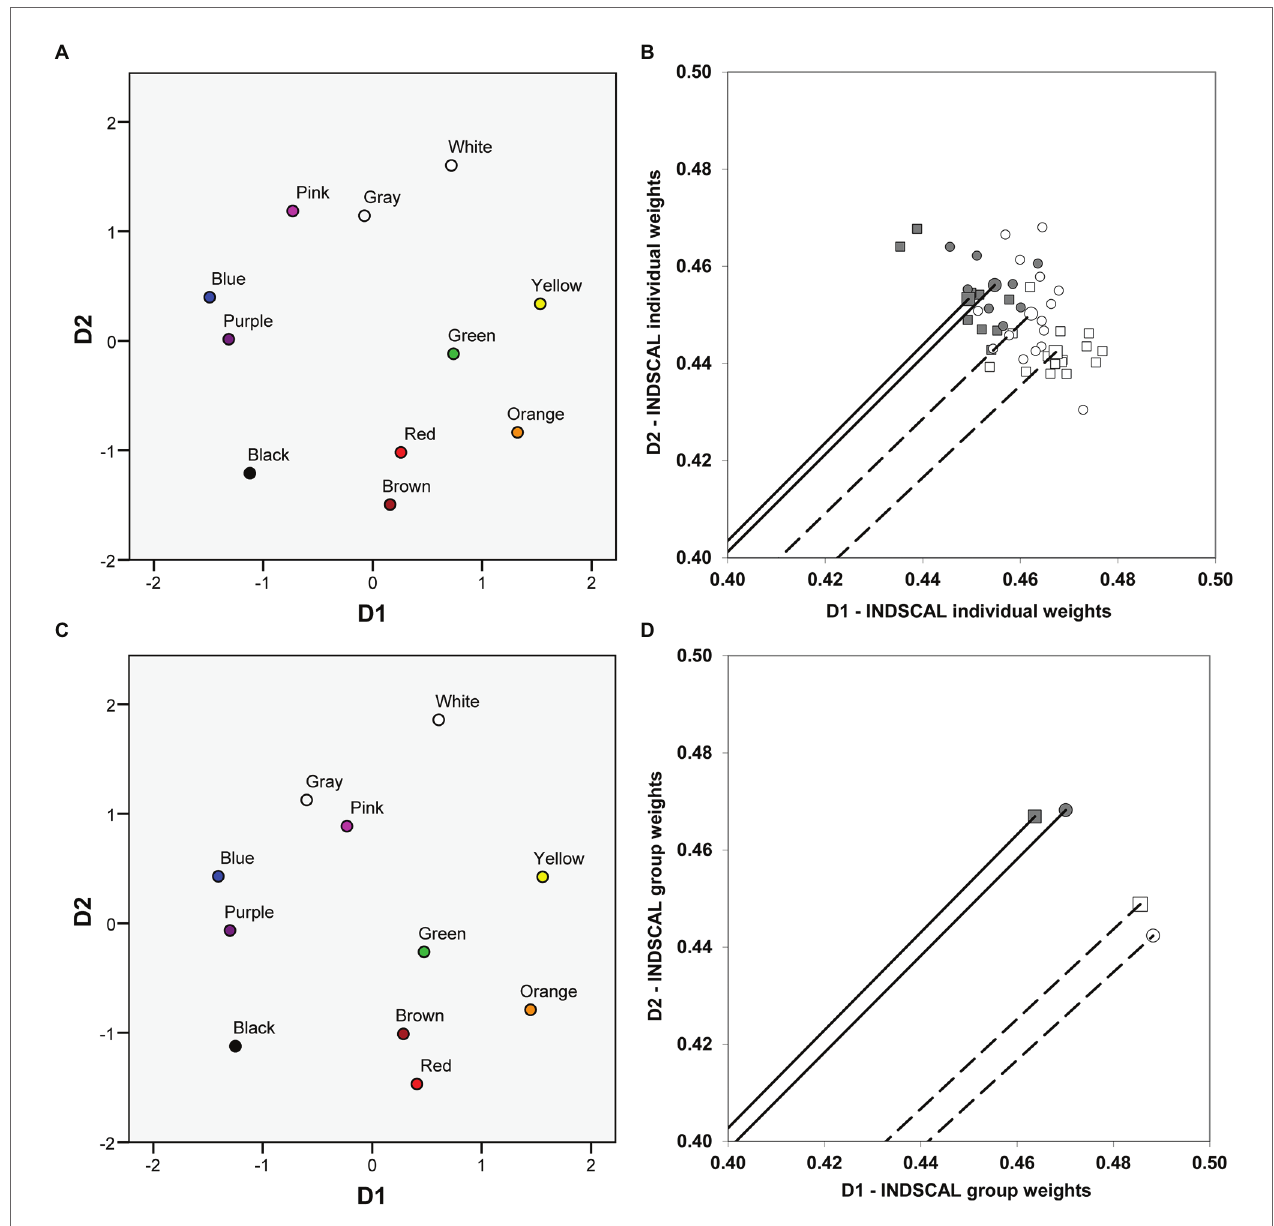
FIGURE 3 | Color planes and dimensional weights obtained in the individual differences scaling (INDSCAL) analyses. The color planes corresponding to the common spaces obtained in the INDSCAL analyses are shown. (A) Individual data. (C) Group data. The weights for D1 (chromatic) and D2 (achromatic) obtained in the INDSCAL analyses for protanopes (circles) and deuteranopes (squares) in the pointing task (dark gray) and the verbal task (white) are shown. (B) Individual data. (D) Group data. Note that axes have been truncated for clarity purposes. Solid lines (pointing task) and dashed lines (verbal task) represent the mean vector (centroid) of individual weights (B) and the corresponding vectors of group weights (D)